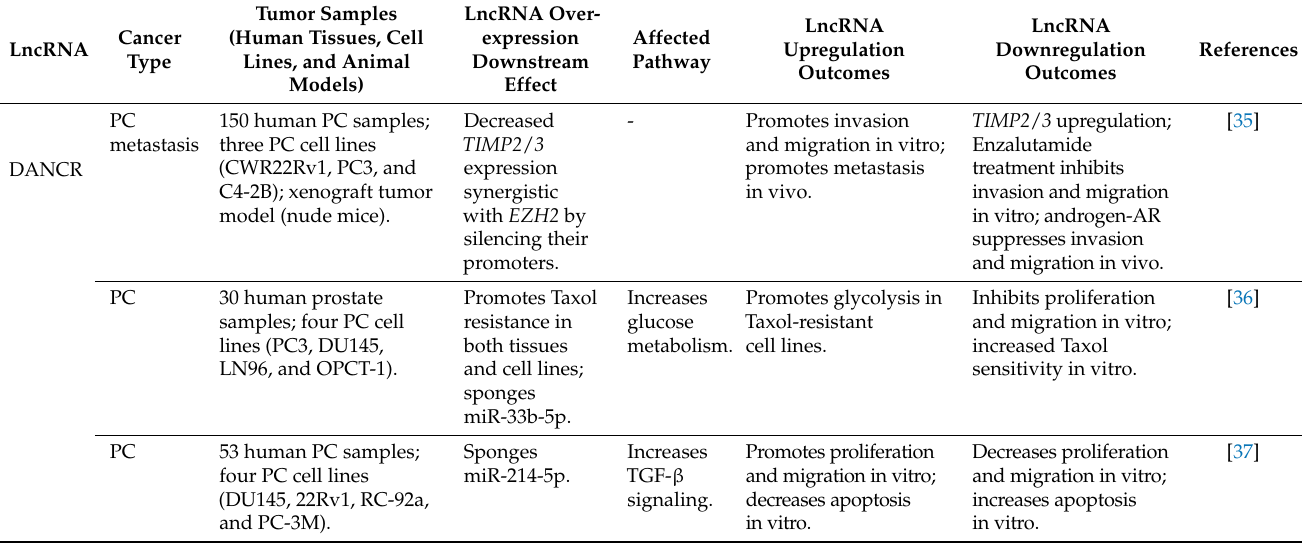
Table 1. List of oncogenic lncRNAs and their effects on PC, OS, and